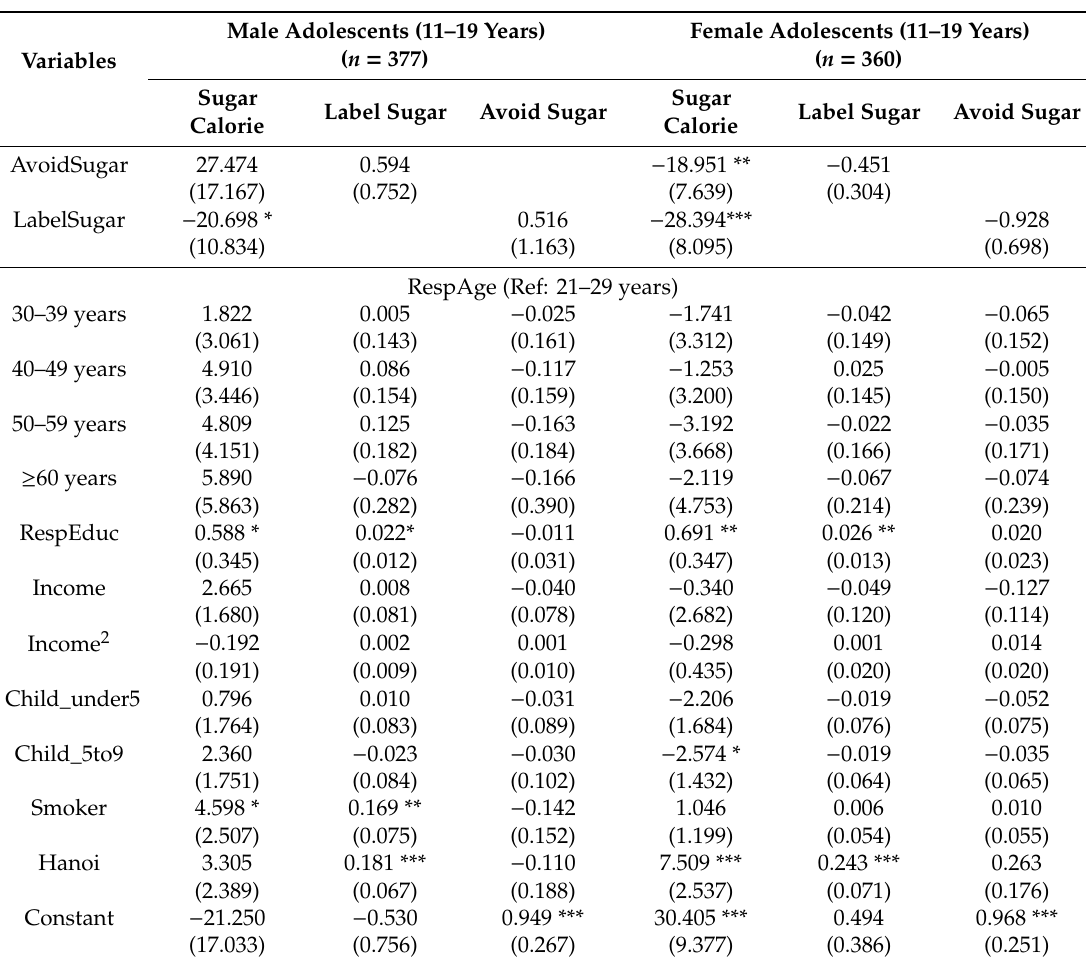
Table 5. 3SLS estimates for